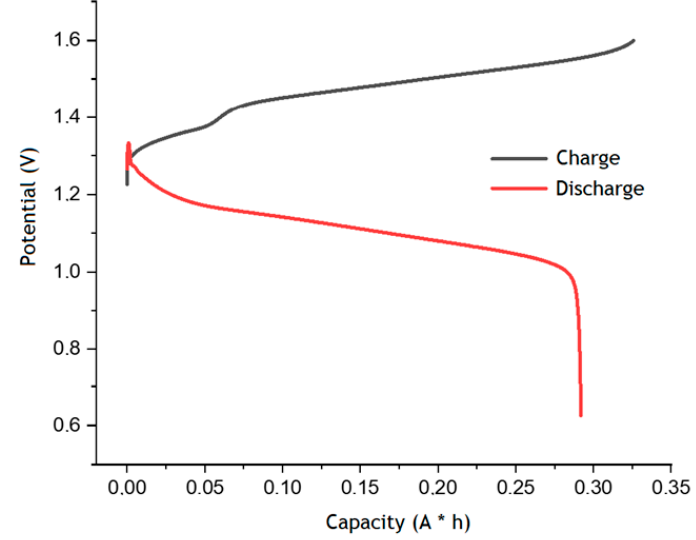
Figure 5. Charge–discharge curves for the second cycle of AQBRFB. Cycling conditions: 50 mA cm − 2 in the voltage range 0.6–1.6 V, flow rate of 100 mL min − 1 . Membrane: Nafion-211, temperature: 50 ◦ C, flow: through flow field, flow rate: 100 mL min − 1 . Posolyte composition: 1 M LiBrO 3 in 6 M H 2 SO 4 , negolyte composition: 0.8 M AQDSH 2 in 1 M H 2 SO 4 .